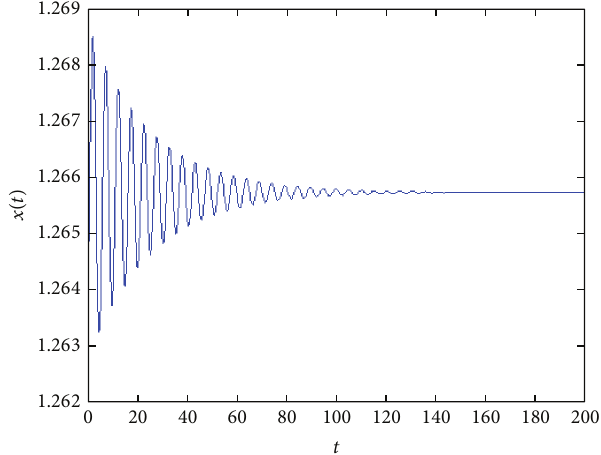
Figure 4: Trajectory that converges to the limit